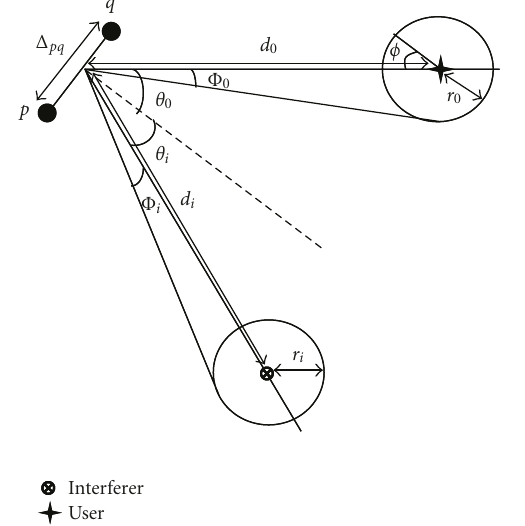
Figure 3: Propagation model for user and interferers: the scatterers are distributed on a rings of radii r i around the